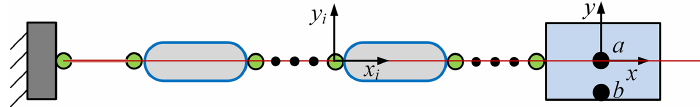
Figure 5. The practical flexure serial